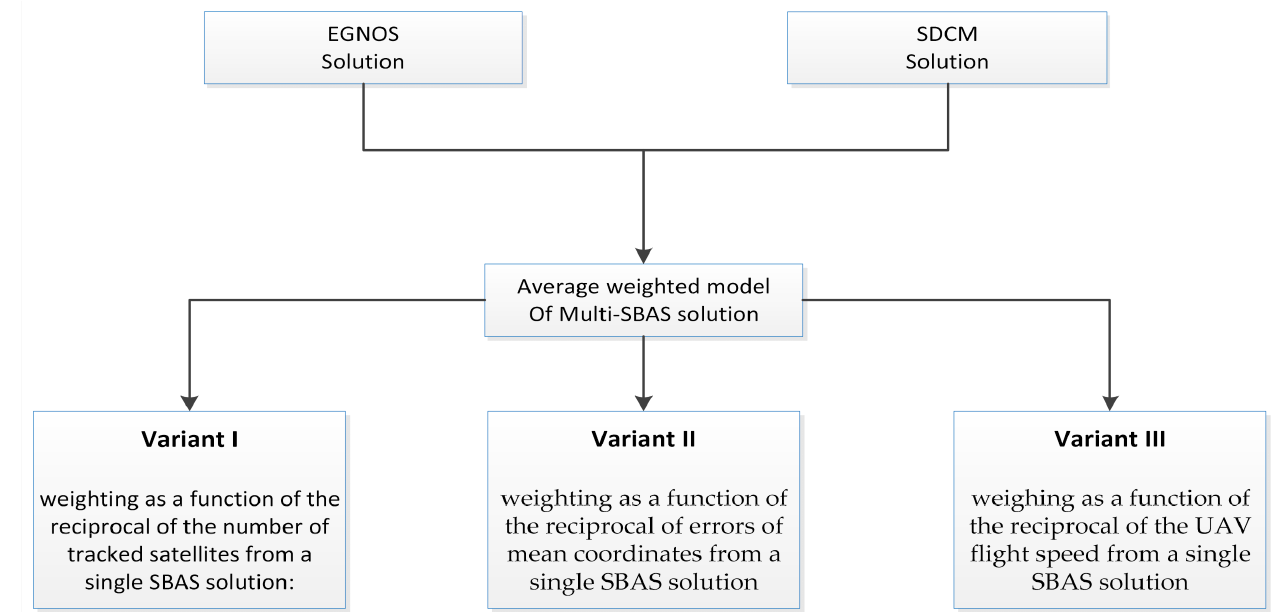
Figure 1. The flowchart of presented research